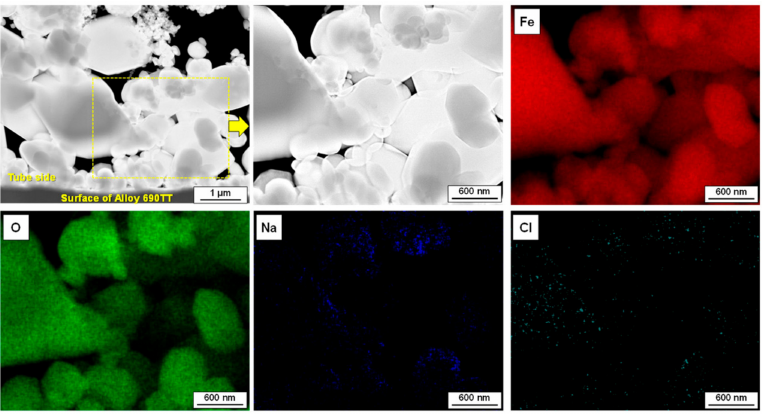
Figure 14. Transmission electron microscope (TEM)-EDS mapping analysis of the Na and Cl impurities in the micro-pores formed on the tube side of simulated magnetite deposits. Table 4. Comparison of the concentration of impurities between both deposit samples.